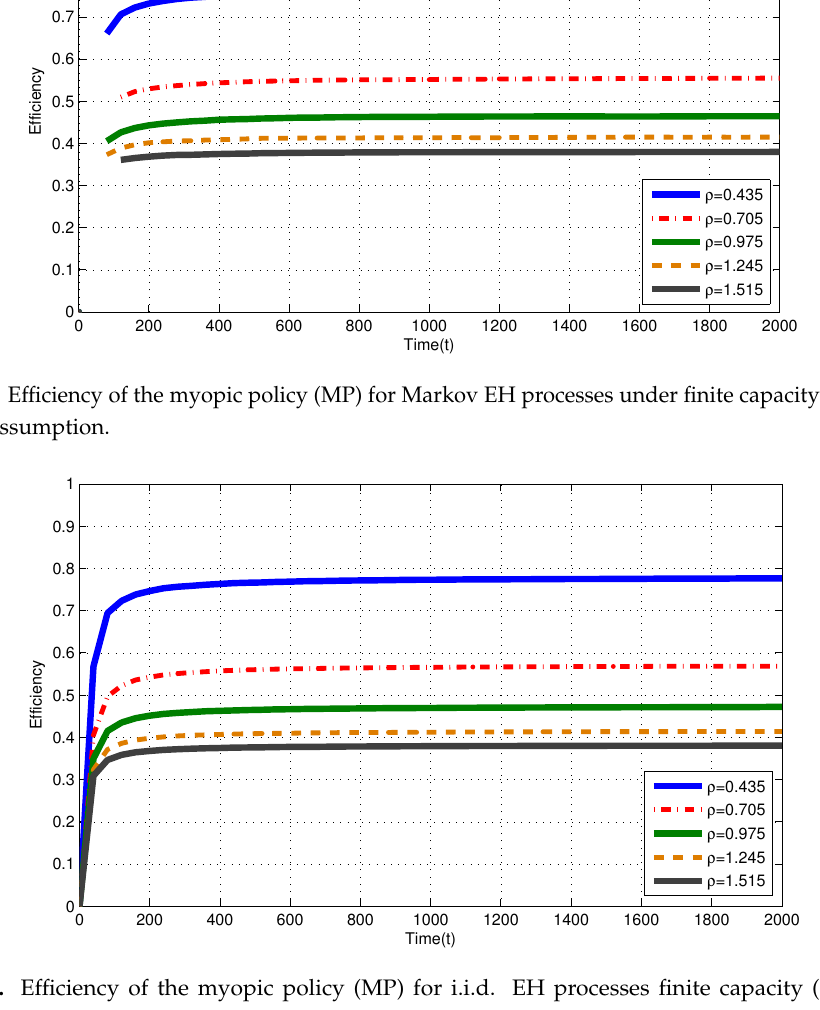
Figure 5. Efficiency of the myopic policy (MP) for i.i.d. EH processes finite capacity ( B i = 50) battery